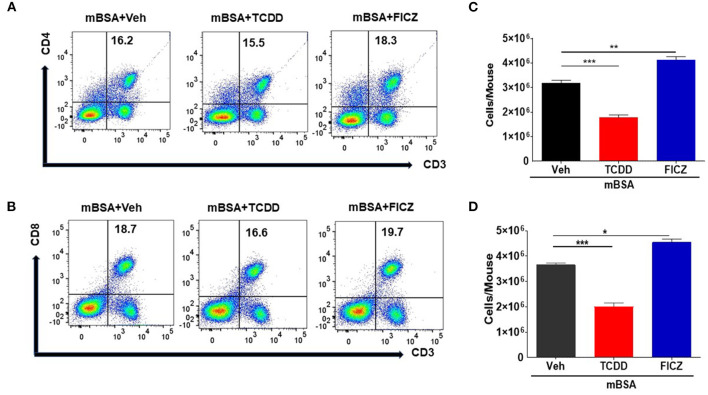
TCDD treatment reduces T cell infiltration in DLNs in mBSA-induced DTH. DTH was induced as described in Figure 1 legend and DLNs were analyzed for T cells. (A) Representative plots from FlowJo software analysis of flow cytometry data showing cells double-stained for CD3 and CD4. (B) Shows absolute cell numbers of CD3+CD4+ T cells in DLNs of various treatment groups. These numbers were calculated based on the absolute number of cells in DLN multiplied by the percentage values of CD3+CD4+ cells obtained by flow cytometry, divided by 100. (C) Representative plots from FlowJo software analysis of flow cytometry data showing cells double-stained for CD3 and CD8. (D) Absolute number of CD3+CD8+ cells. The statistically significant differences between the groups were calculated using one-way ANOVA. Vertical bars represent Mean ± SEM and significant differences between groups were indicated by asterisks (*p < 0.05, **p < 0.01, ***p < 0.001).